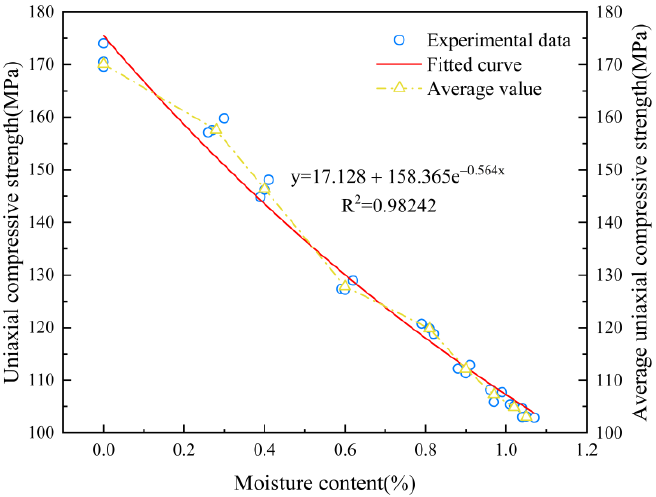
where y is the uniaxial compressive strength, and x denotes the moisture content. The correlation coefficient of the fitted function was R 2 = 0.98242.